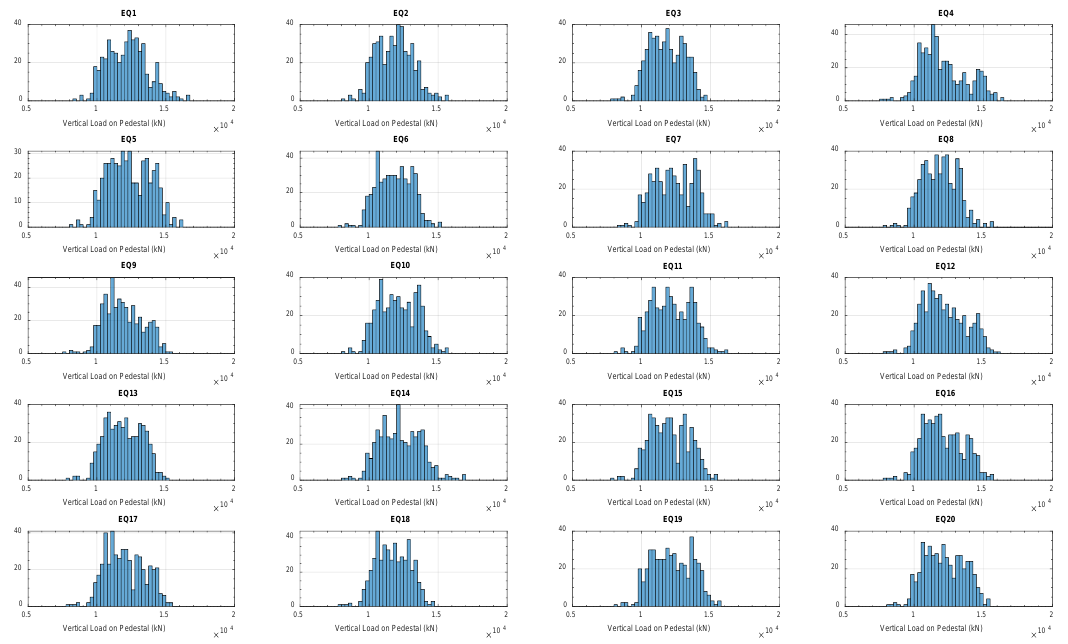
Figure 20. Vertical load distribution on the 486 isolators under 20 ground motions (PGA = 1.0 g).